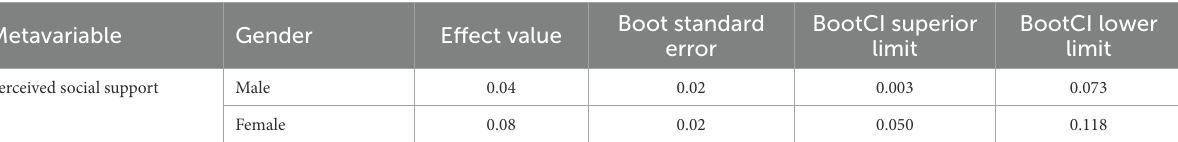
TABLE 5 The mediation effects of social support.